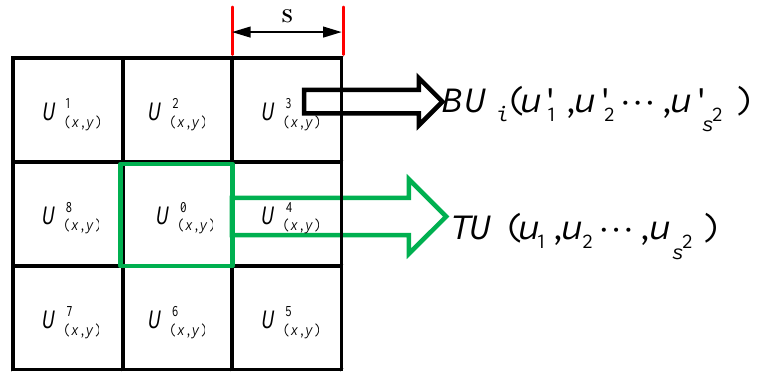
Figure 1. Regional patch